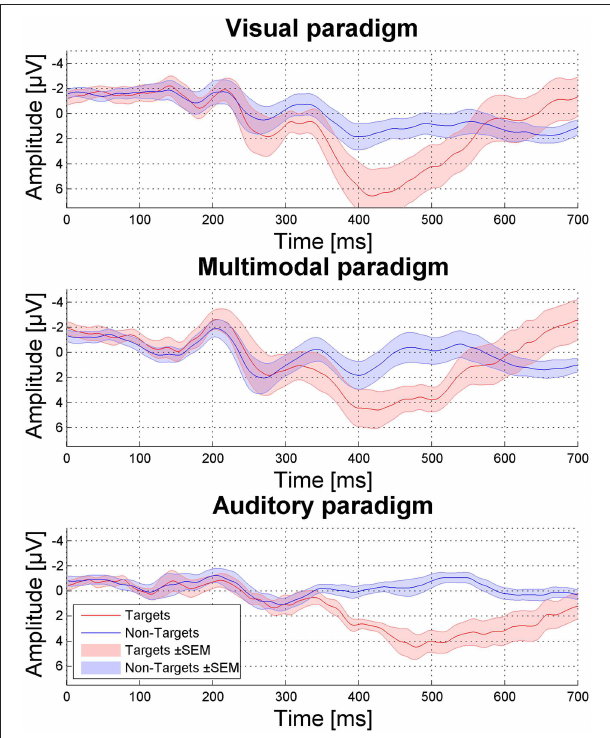
FIGURE 3 | P300 amplitudes for the three spelling paradigms depicted from Cz. Red and blue shades indicate the standard error of the mean (SEM).